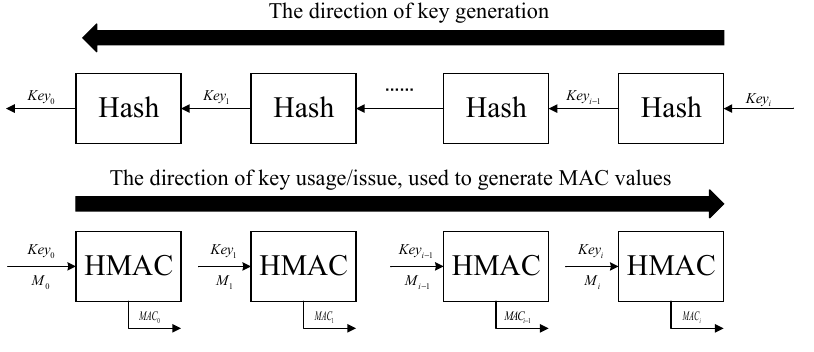
Figure 5. Key chain generation and key usage of TESLA.